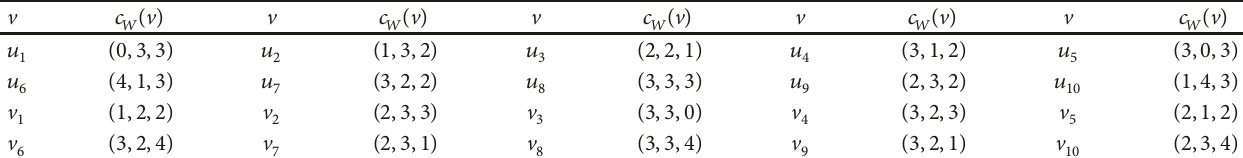
Table 7: The code 𝑐 𝑊 ( V ) of V with respect to 𝑊 = {𝑢 1 ,𝑢 5 , V 3 } in 𝑃(10, 4) .